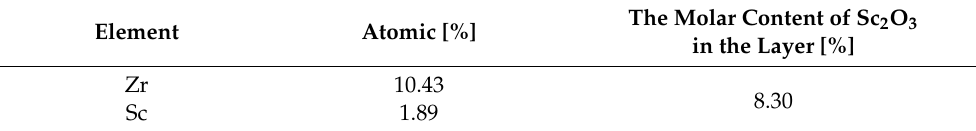
Table 1. Average chemical composition determined by EDS analysis and calculated molar content of Sc 2 O 3 in the layer (Figure 1). The synthesis temperature: 600 °C. Total gas pressure: 6580 Pa. The molar content of Sc(tmhd) 3 in the gas mixture: 14%. The layer was deposited without the presence of air.